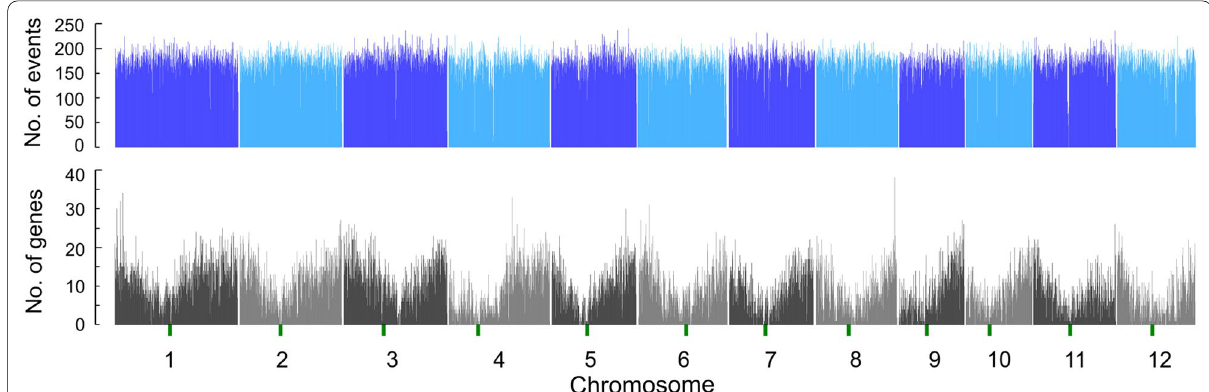
Fig. 1 Distribution of SNVs along rice chromosomes at a 100 kb sliding window. The upper and lower bar charts represent the distributions of SNVs and genes annotated by IRGSP-1.0, respectively. The centromeres are marked with green vertical bars under each chromosome number in the gene distribution chart